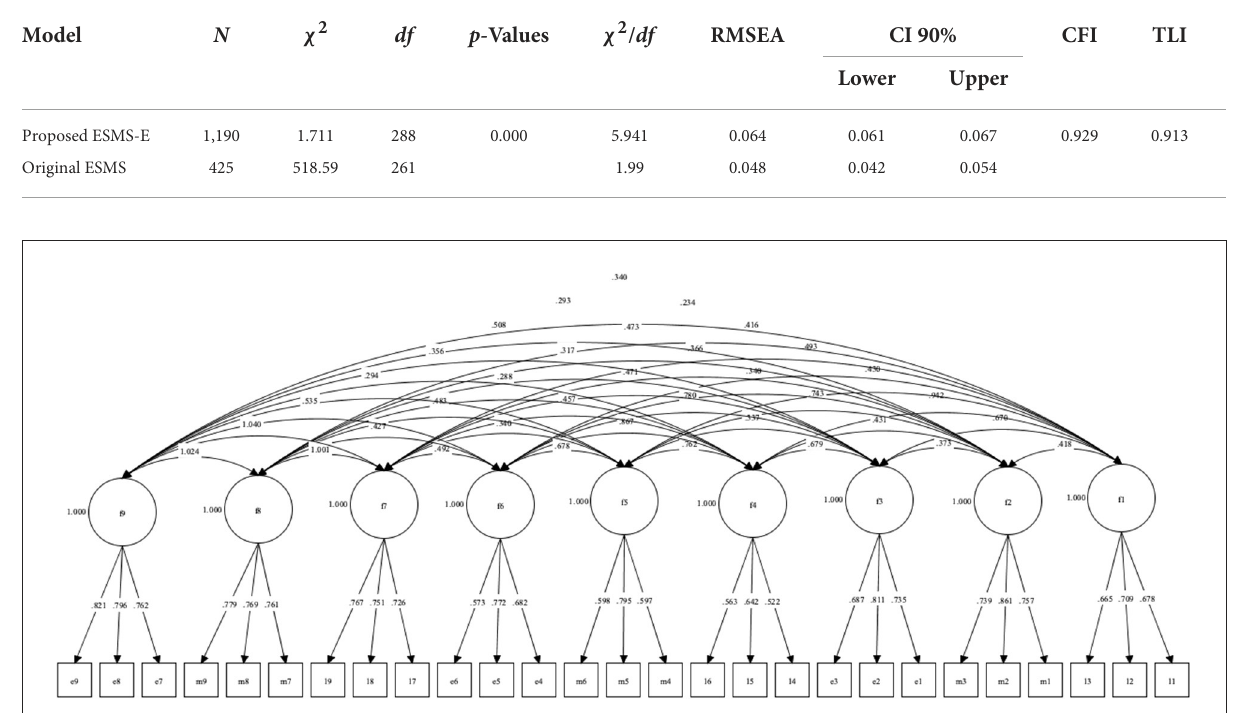
TABLE 5 Goodness of fit model comparison.